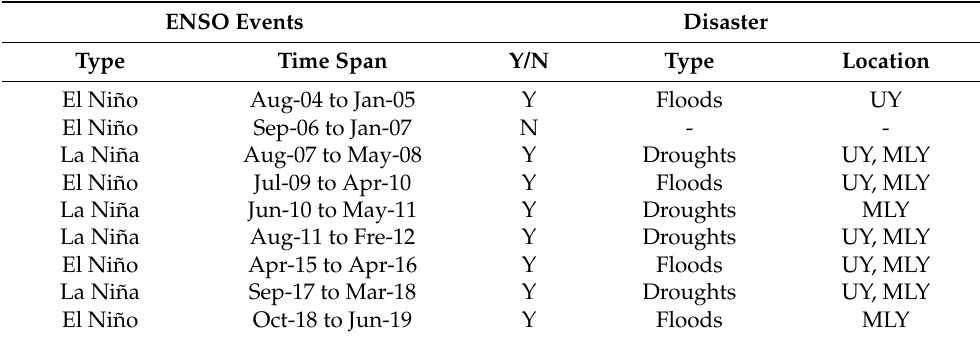
Table 7. The drought and flood events statistics during and after ENSO events in the